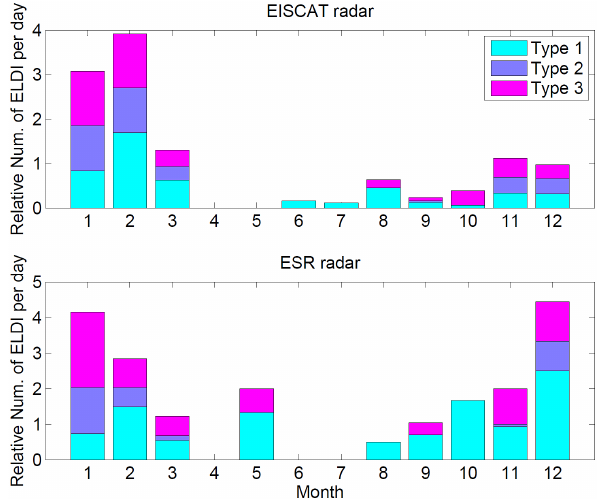
Figure 10. Number of ELDIs of various types in each month at EISCAT/ESR sites during 2009–2011.